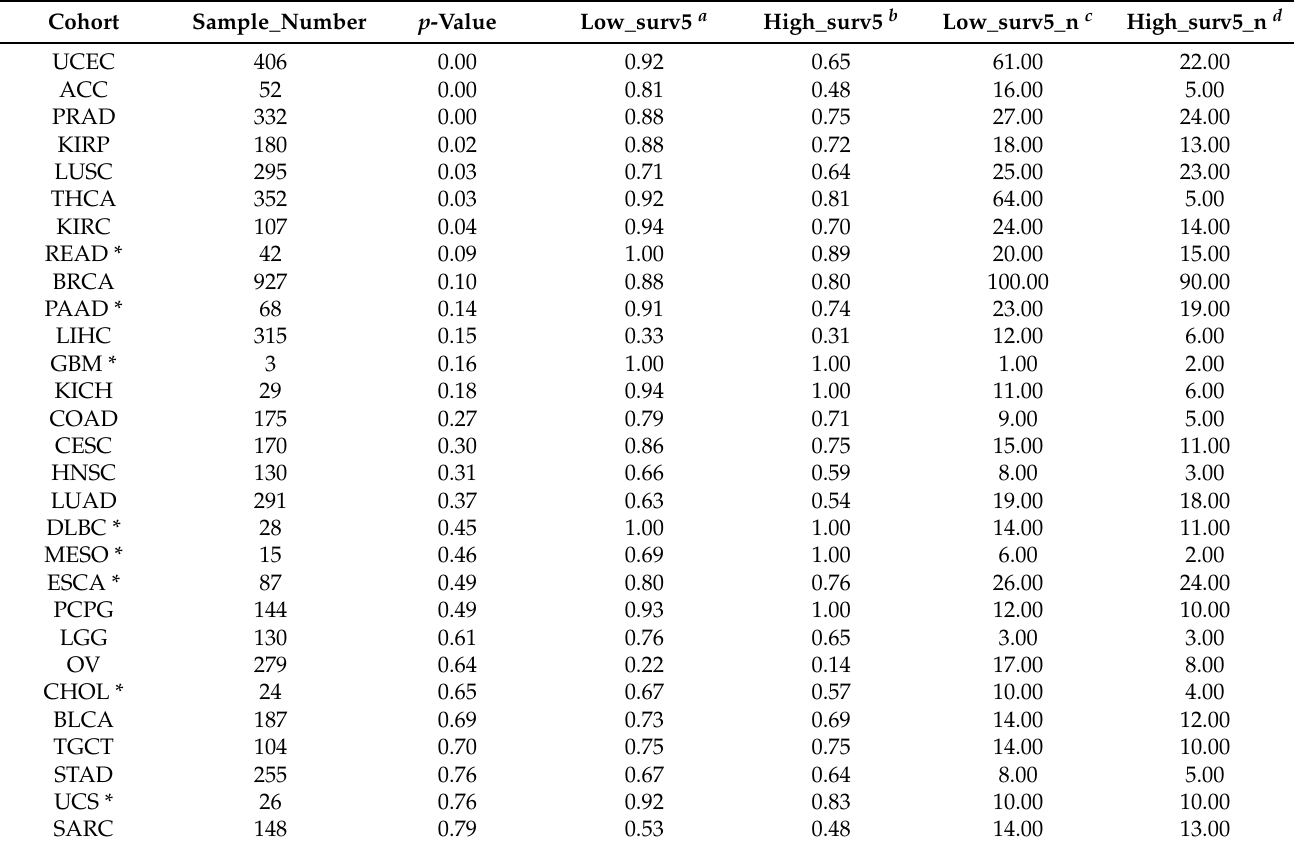
Table A4. Association between S-CIN and disease-free survival across cancer